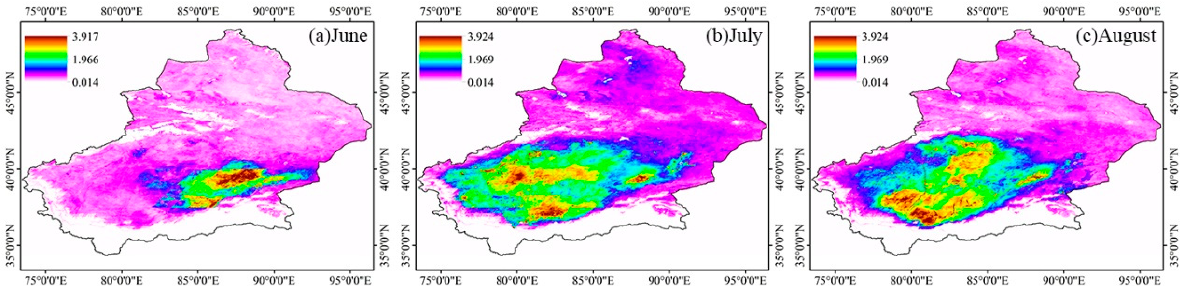
Figure 1. Spatial distribution of AOD in Xinjiang from June to August. Vegetation is extremely scarce in the TD, as the surface is primarily composed of very fine sands (shifting sand with a light weight, fine grain size, and strong mobility) [49]. The relative height of NNE–SSW- or NE–SW-trending ridges is 40–50 m; ridge width is 1–3 km, and the length is 2–5 km. There are crescent-shaped dunes and sand-dune chains on the front edge of the sand ridges. Approximately 5.3 Ma, mobile dunes prevailed in the Tarim Basin [50]. TZ station (83 ◦ 39 (cid:48) E, 38 ◦ 58 (cid:48) N; 1099.3 m.a.s.l.) is the only comprehensive observation experimental station of atmospheric science in the world established deep in the hinterland (>200 km) of the TD (Figure